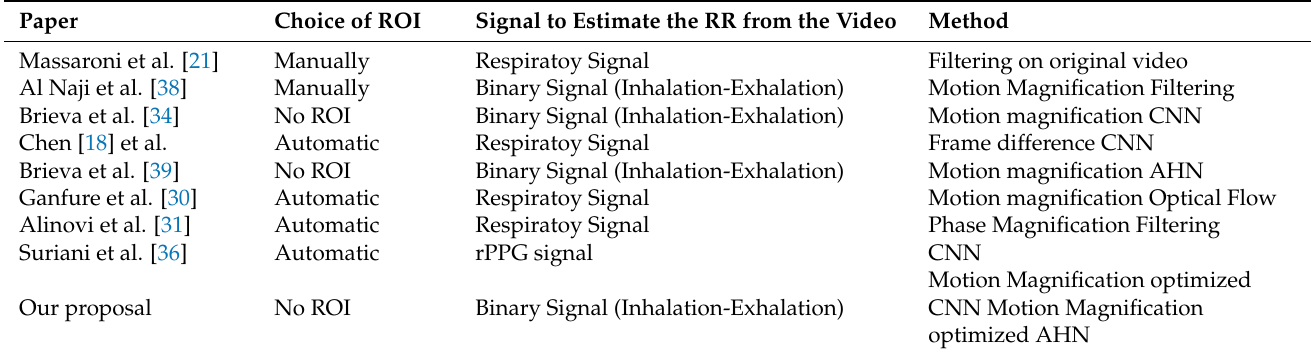
Table 11. Principal works to estimate the respiratory rate.